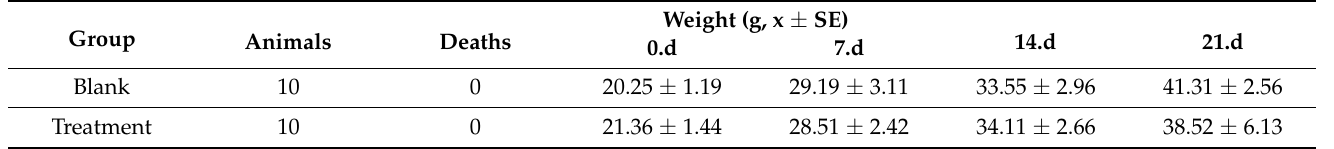
Table 2. Effects of naringin on mouse body